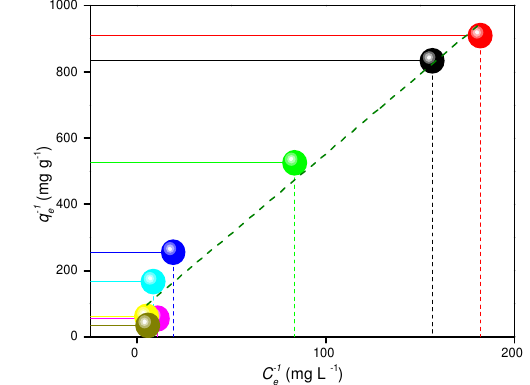
Fig. 8: Langmuir Isotherm (Adsorbent Dose 0.5g Per 50 ml, pH 6, Shaking Time 2hrs, Temperature 25 ± 2 O C, at different As(III) Concentrations with Shikarap Iron Ore)